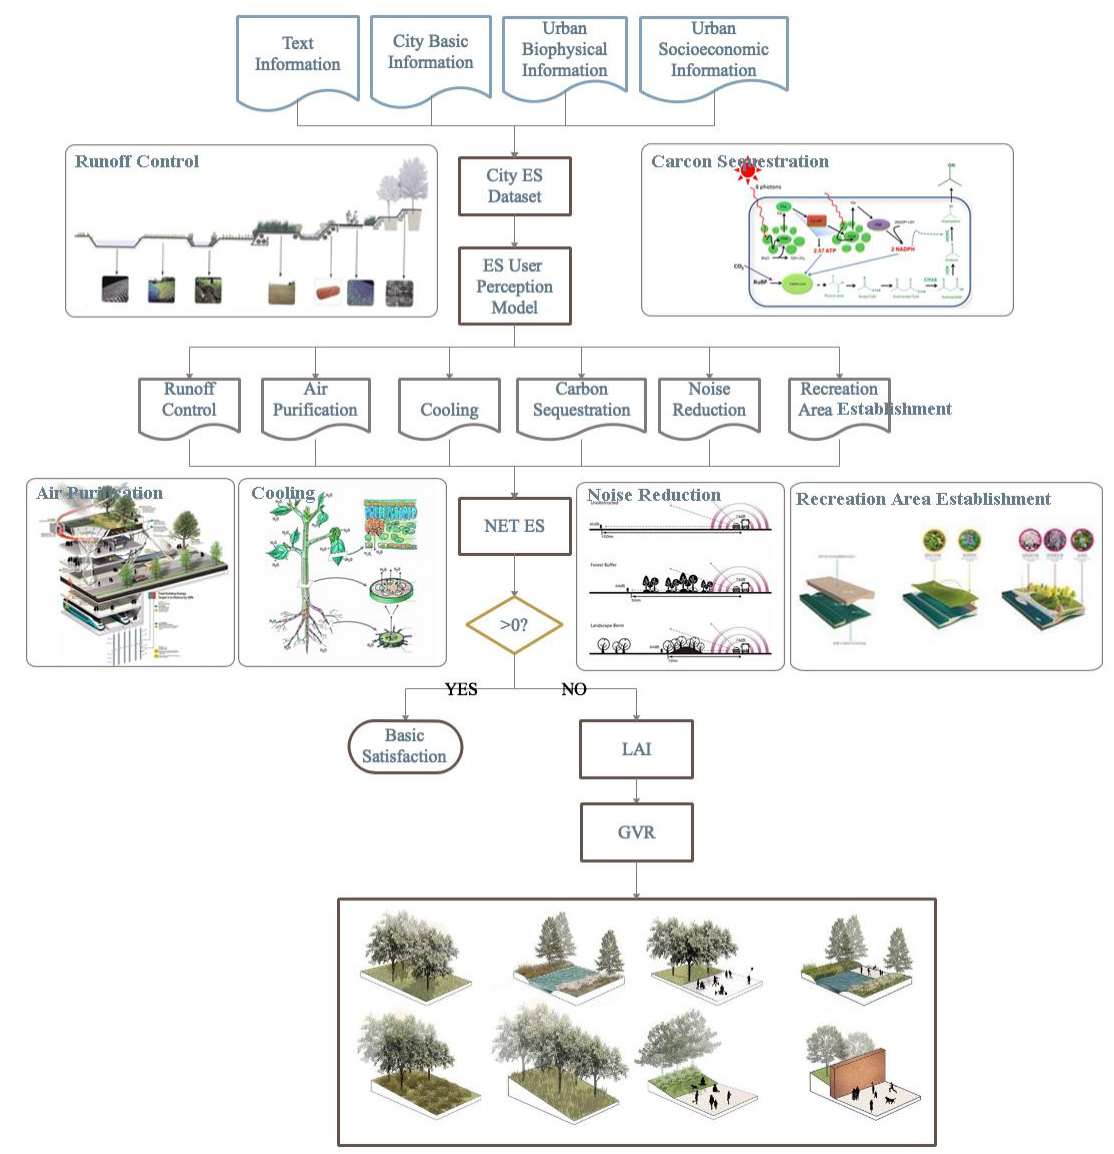
Figure 2. Proposed model architecture diagram.